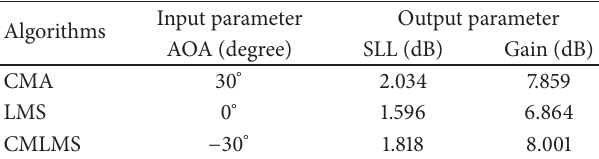
Figure 6: Convergence behaviors of CMLMS, LMS, and CMA algorithms. Table 2: Performance